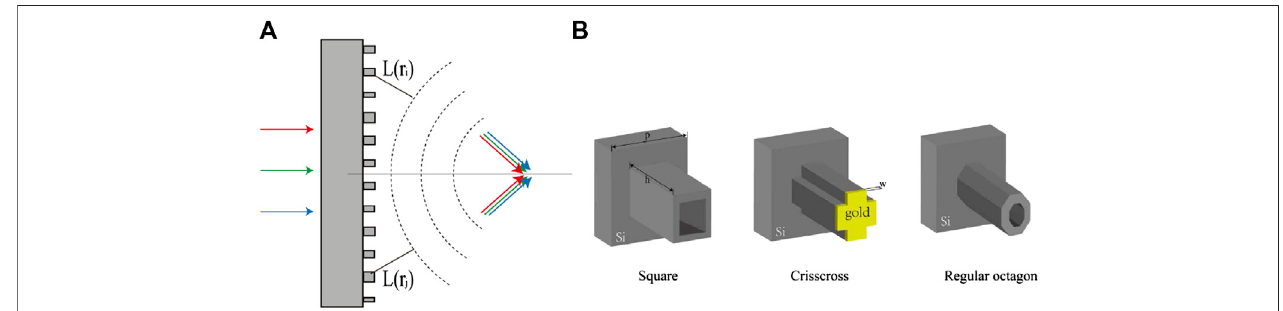
FIGURE 1 | (A) The schematics of the achromatic meta-lens. The dashed lines represent the focusing wave front while the colored arrows represent the propagatingdirectionsoftheterahertzwavesatdifferentfrequencies. (B) Theschematicsoftheadoptedpillarstructureswithdifferentcrosssectionshapes;theheightis 190 µm and the periodicity 130 µm. The yellow layer represents a gold layer of thickness 200